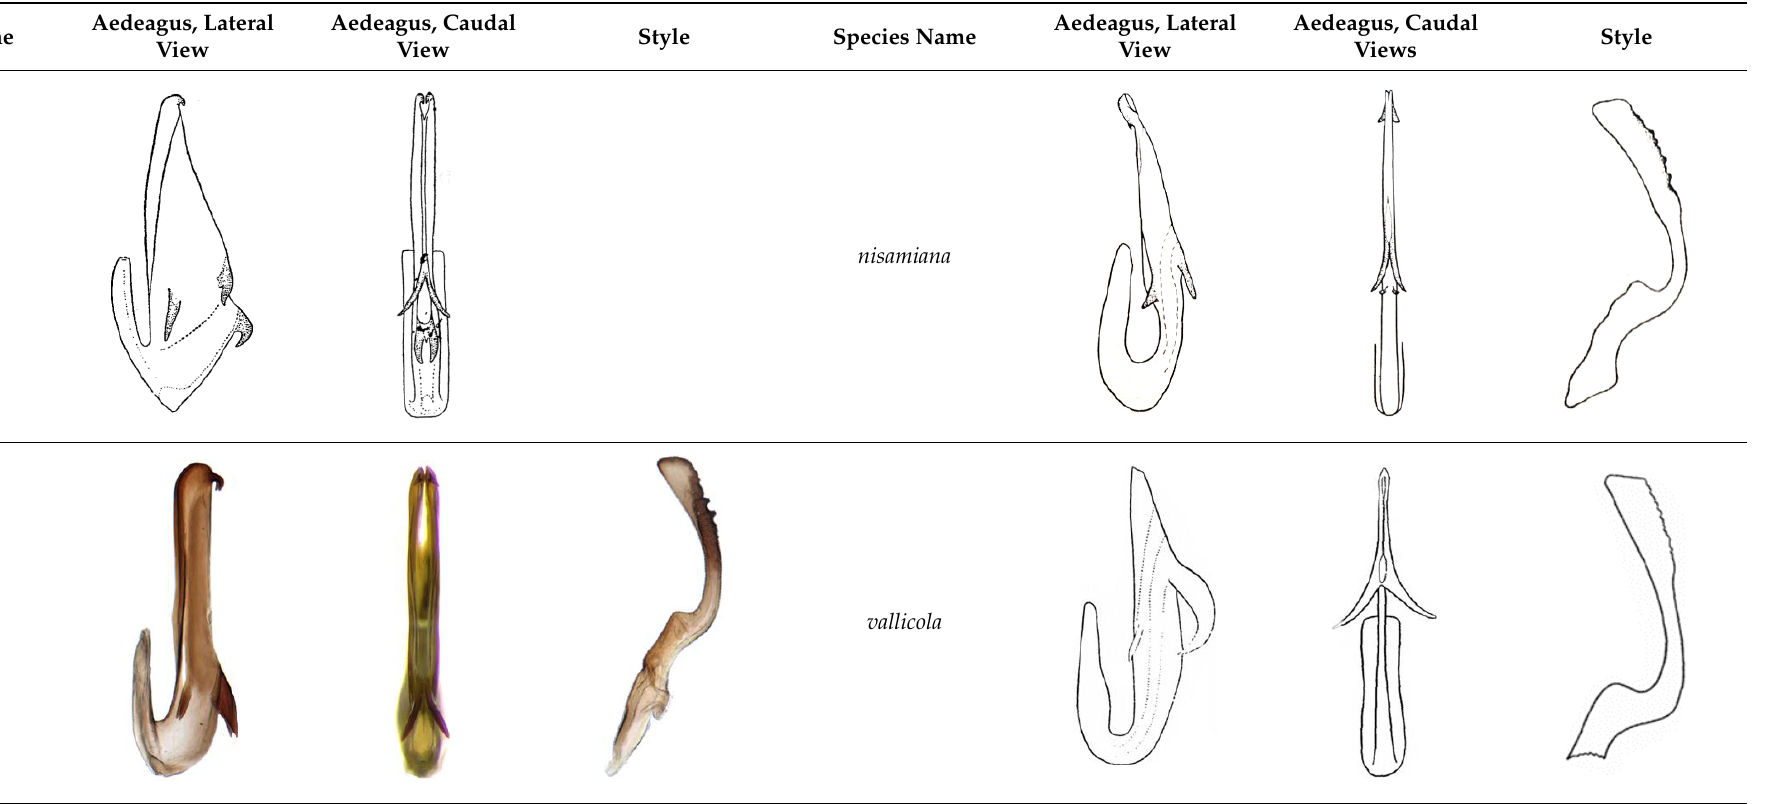
List of morphological characters used in phylogenetic analyses, body and head